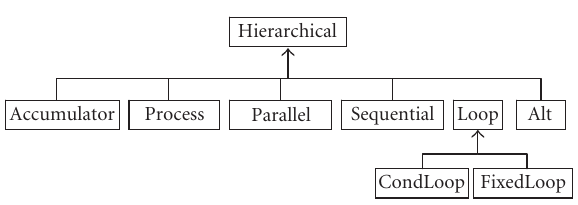
Figure 3: Hierarchical node inheritance tree in our CDFG